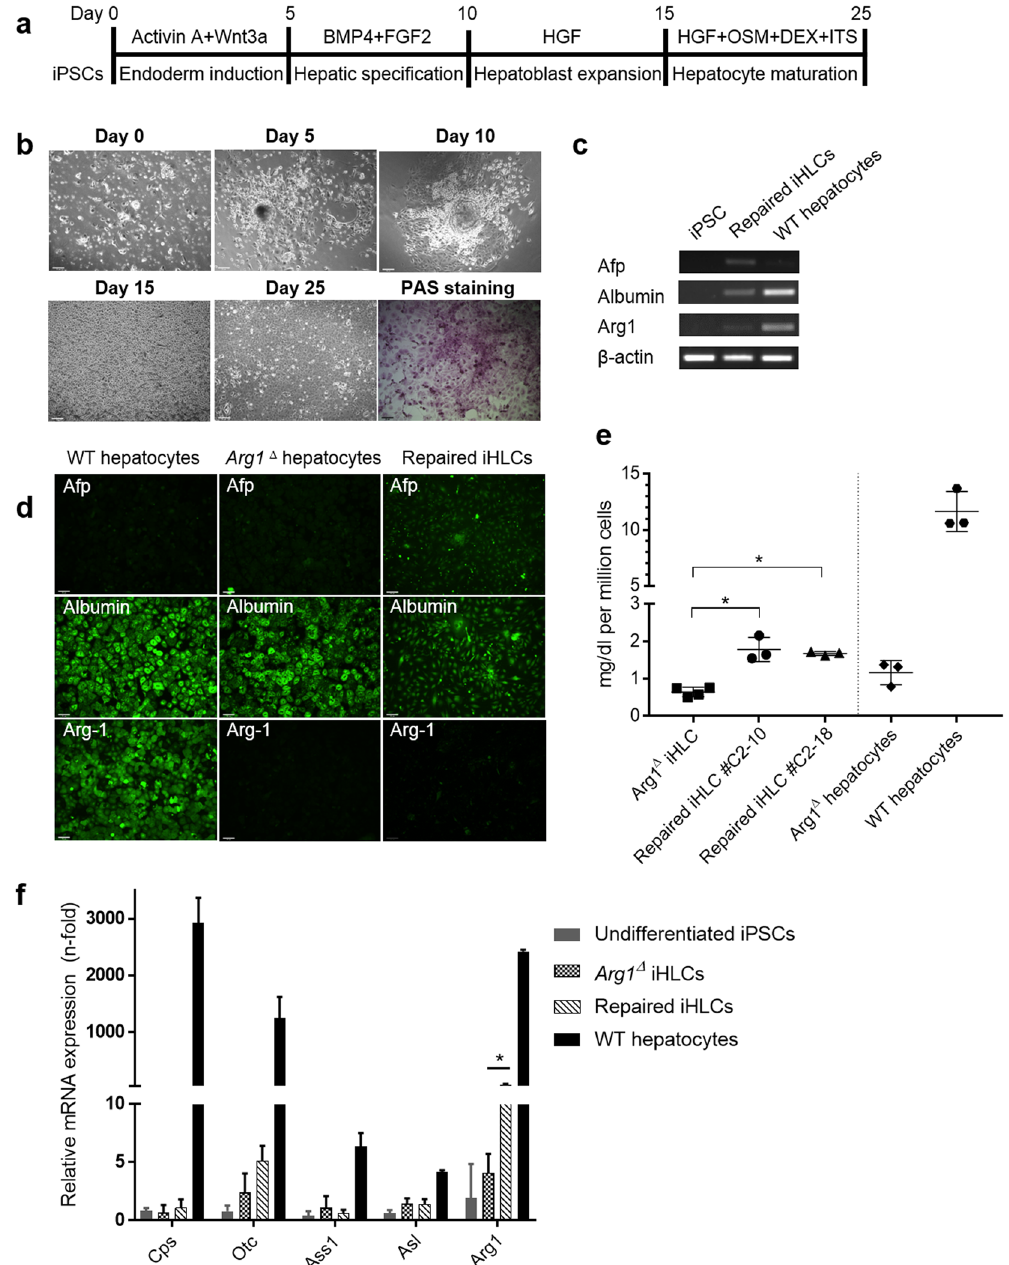
Figure 4. Generation of hepatocyte-like cells from repaired mouse iPSCs. ( a ) Schematic diagram showing the stepwise hepatic differentiation protocol. ( b ) Representative phase contrast images showing sequential morphological changes in iPSCs at different stages of differentiation (10x magnification). The cells are positive for PAS staining at day 25 after the start of the differentiation procedure. ( c ) RT-PCR gene expression of iHLCs for the hepatocyte markers alpha-fetoprotein (Afp), albumin and Arg1. Expression of genes was normalized to β -actin. ( d ) Representative immunostaining images from two independent batches of hepatic differentiation showing the expression profile. ( e ) Functional characterization of iHLCs. After 24 h of culture, supernatants were collected for urea production assay. Values were normalized by the number of cells seeded. Values are mean ± SD for n = 3 − 4. ( f ) qPCR expression analysis of the five urea cycle enzymes. The C t values of all genes were normalized to the C t values of 18S rRNA. The y-axis represents the fold-change of gene expression compared with undifferentiated iPSCs. Values are mean ± SD for n = 3. Statistical significance between groups was determined by Student’s t -test ( * P <